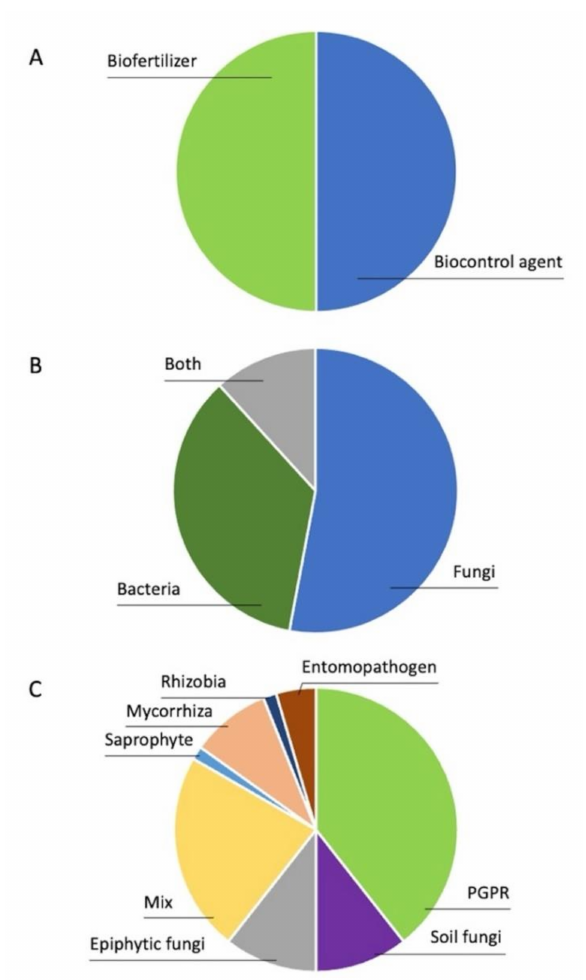
Figure 1. Microbiological tools, available in 2021 for agriculture (Supplementary Table S1) with published field test reports by ( A ) application, ( B ) organism, and ( C )